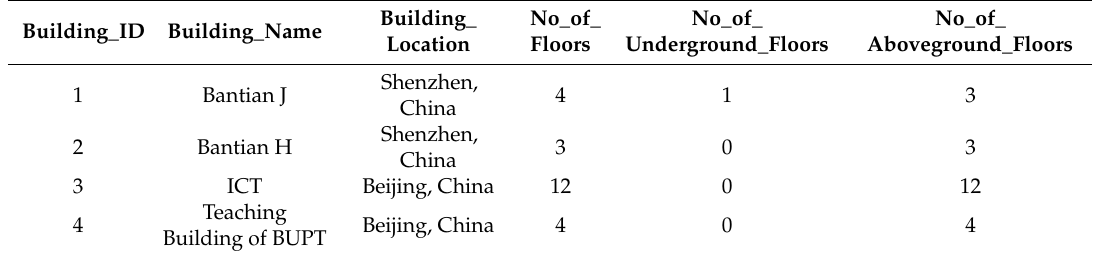
Table 1. The structure of four buildings to evaluate the BWFP